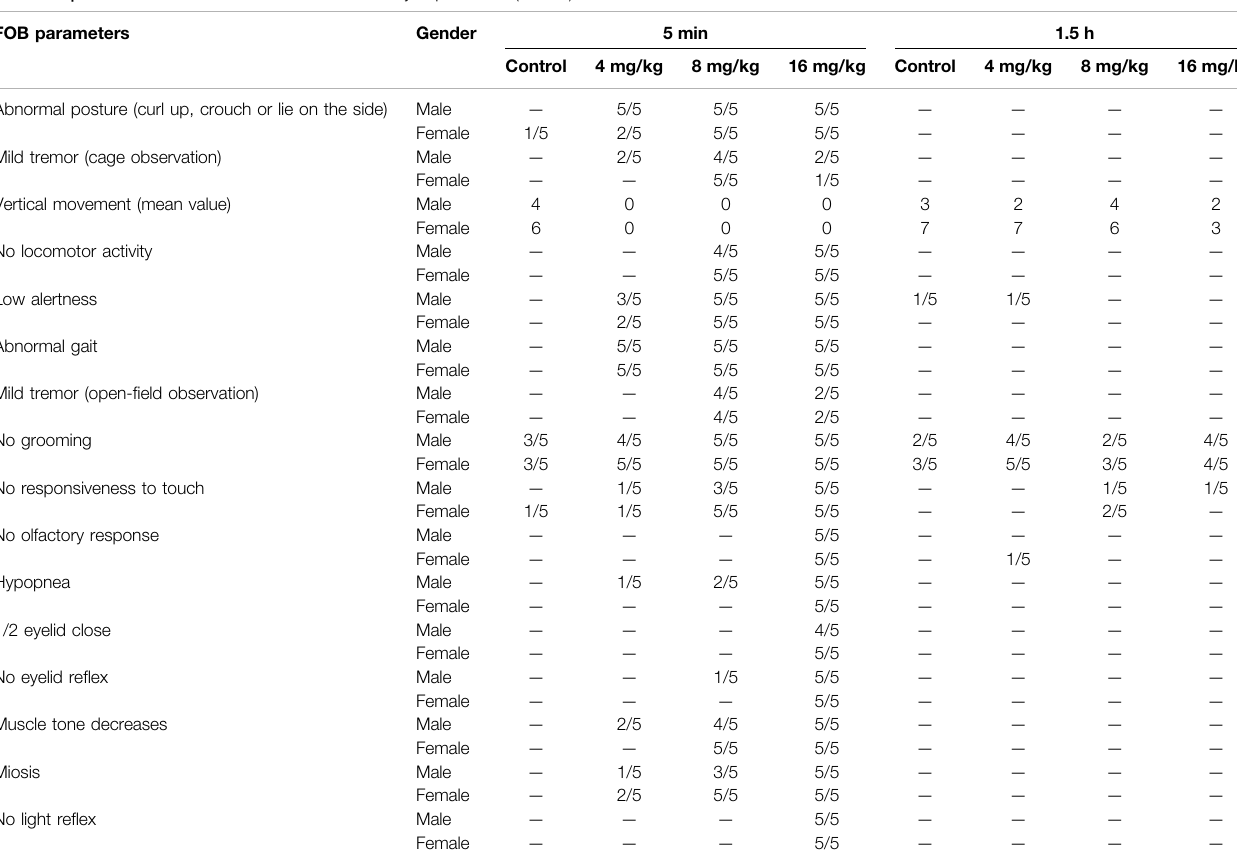
TABLE 1 | The result of functional observational battery experiments ( n (cid:1)